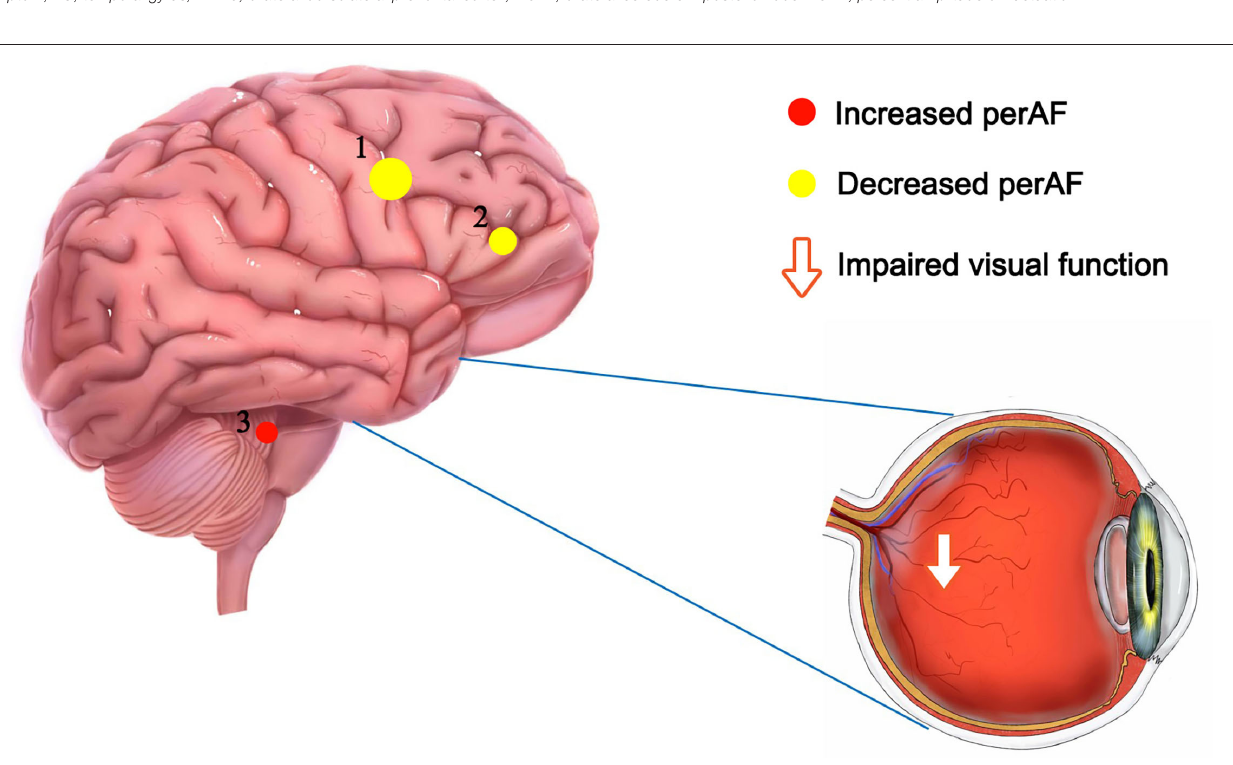
FIGURE 5 | The mean perAF values of ROIs. Compared with the HCs, the PerAF values in Precentral_L ( t = − 4.3502) and Frontal_Sup_Medial_R ( t = − 3.8795) were increased and the PerAF value in Caudate_L ( t = 3.8544) was decreased. PerAF, percent amplitude of fluctuation; HCs, healthy